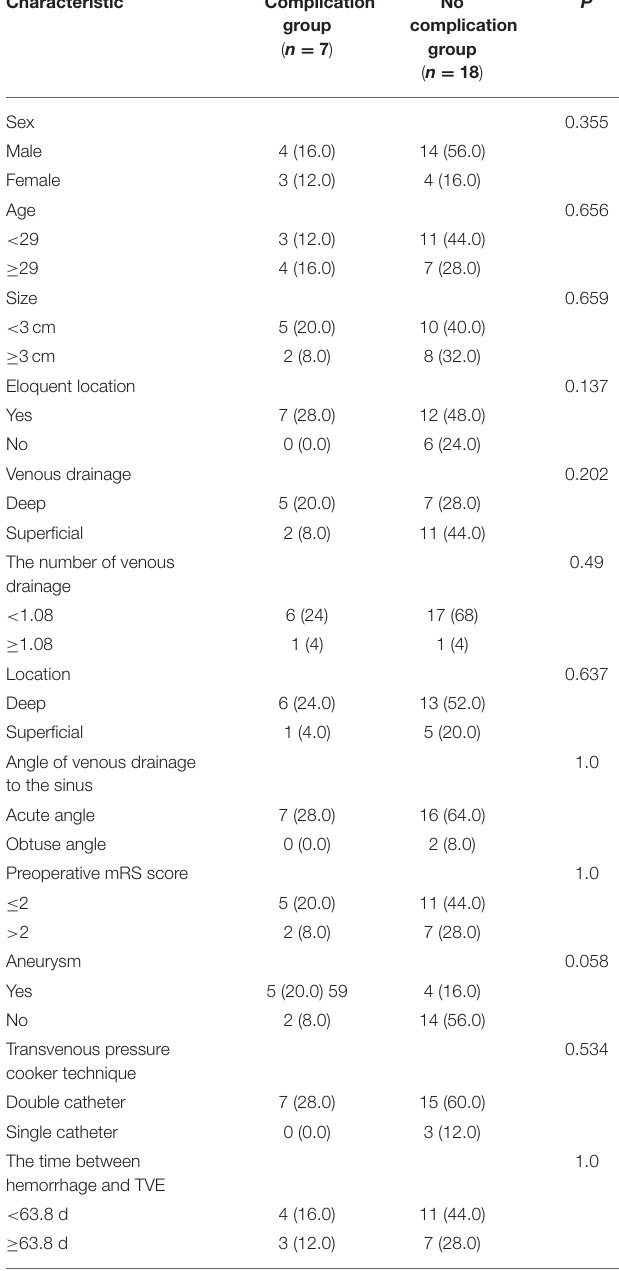
TABLE 2 | Complication group vs. no complication